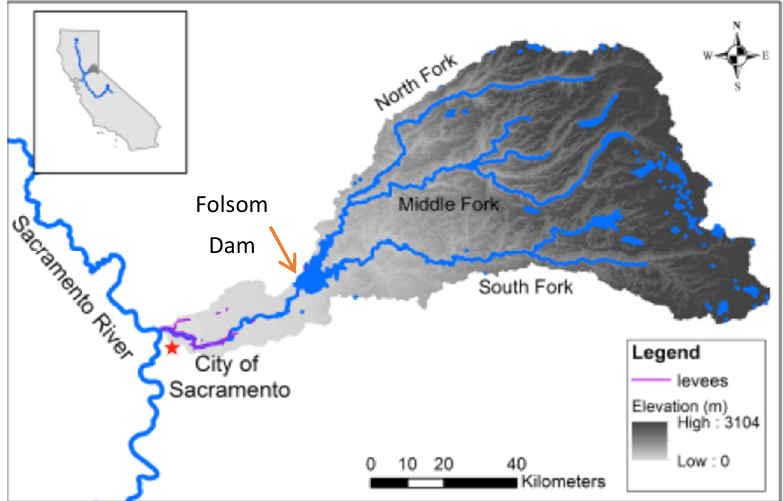
Figure 1. Map of the American River Basin, CA showing major State Plan for Flood Control (SPFC) project works.